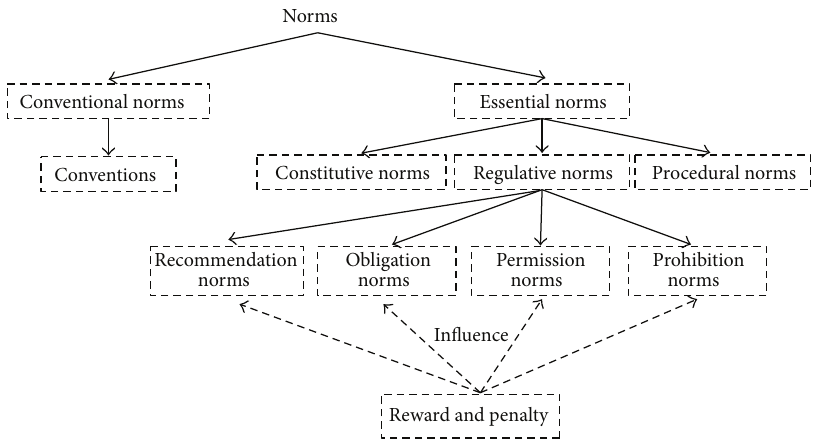
Figure 2: Modified norms classification architecture.